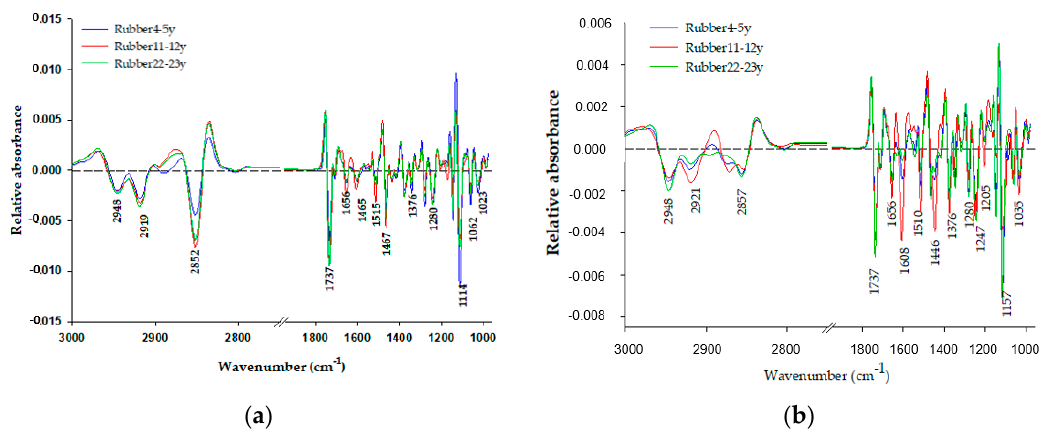
Figure 4. An overlay of second-derivative average spectra from differently aged rubber tree plantations: ( a ) Epidermis and ( b ) mesophyll. The average second derivative spectra were calculated after 13 points of smoothing and normalization, with extended multiplicative signal correlation over the spectral ranges of 3000–2800 and 1800–900 cm − 1 .